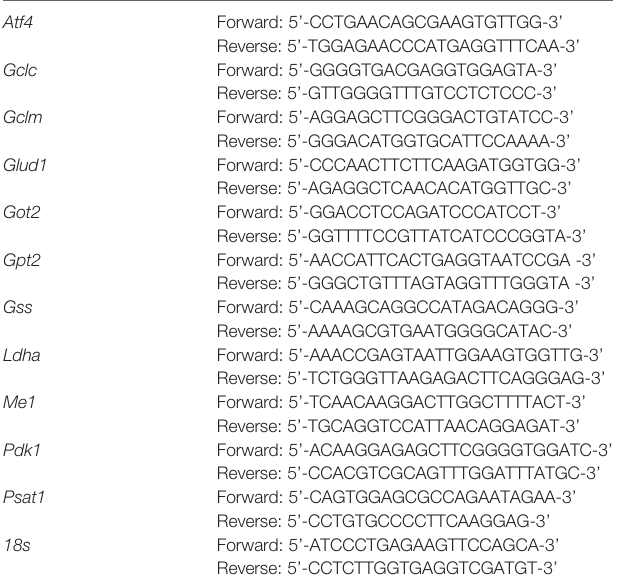
TABLE 1 | Primers used for